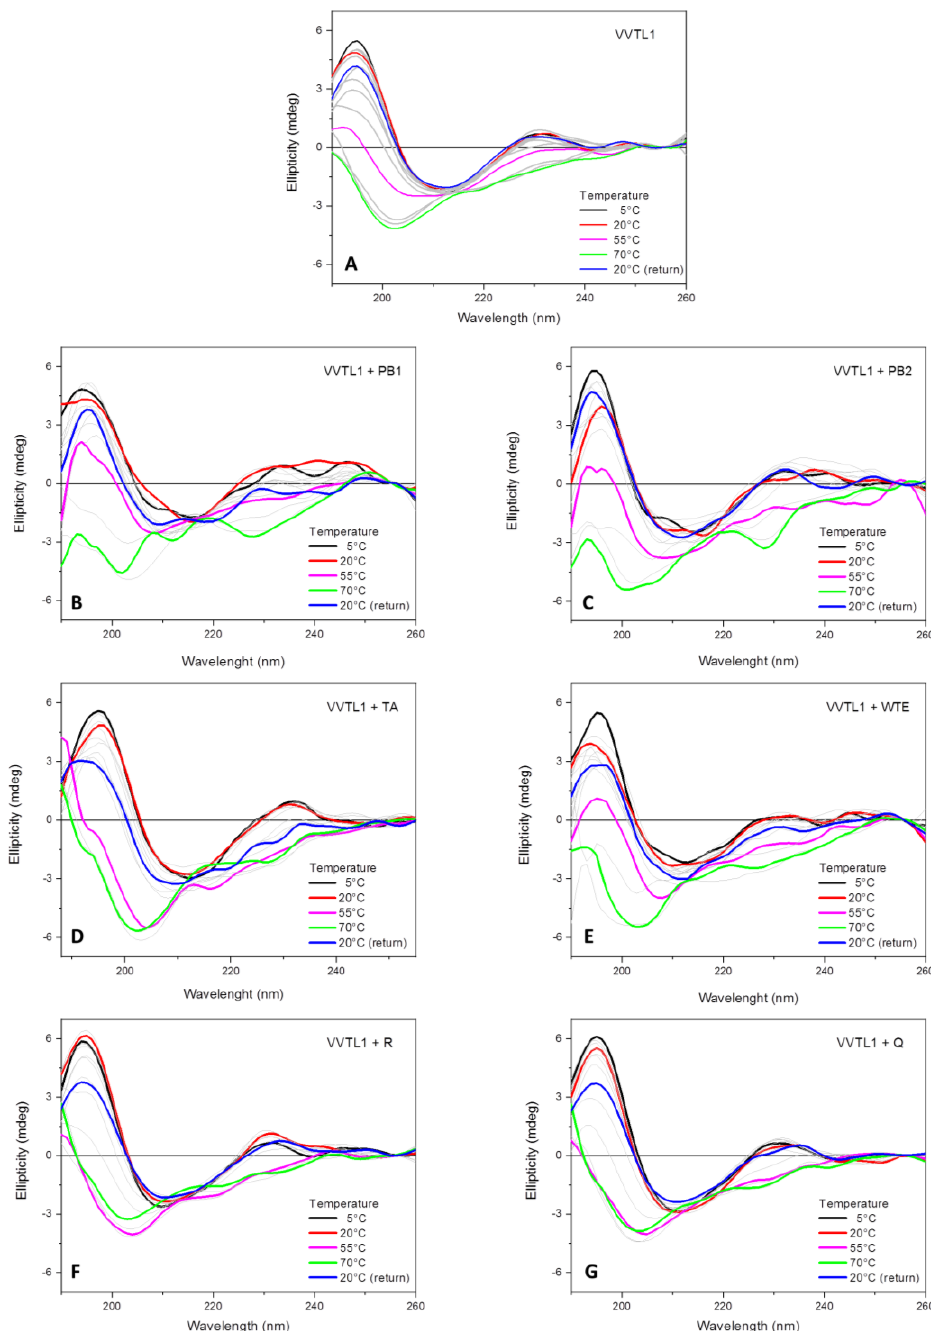
Figure 5. Thermal denaturation experiments: far-UV SRCD spectra of VVTL1 (0.400 mg/mL in MWS) alone ( A ) and in presence of Procyanidin B1 (PB1) ( B ) and B2 (PB2) ( C ), tannic acid (TA) ( D ), Wine Tannins Extract (WTE) ( E ), Rutin (R) ( F ), and Quercetin (Q) ( G ) were recorded at different temperatures (indicated) using a Suprasil 0.02 cm cell (Hellma) filled with 60 µL of solution, integration time 1 s, 1 nm digital resolution, 39 nm/min scan speed and monochromator slit widths to 1.2 nm bandwidth. Grey lines indicate intermediate temperatures with steps of 5 °C.